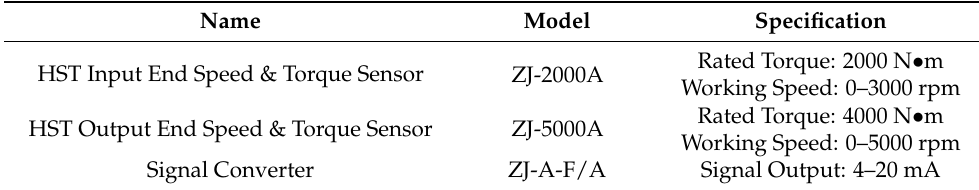
Table 1. Related specifications of the speed and torque sensors used in the test.